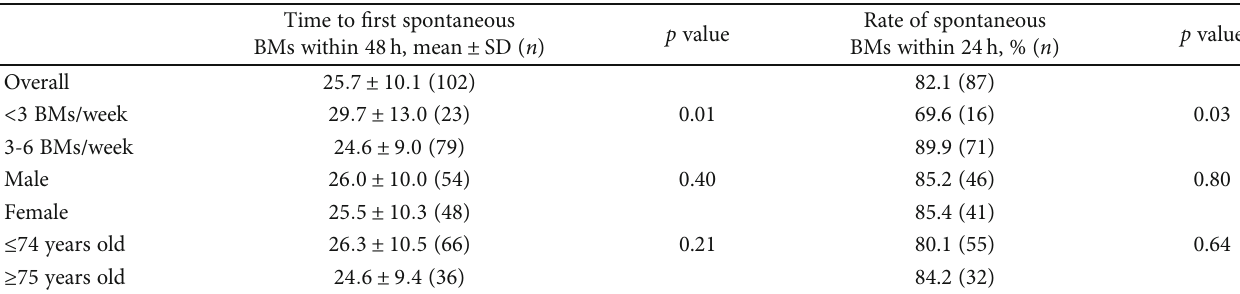
Table 4: Time to fi rst SBMs and rate of SBMs within 24h after prescription of short-duration PEG+E. Time to fi rst